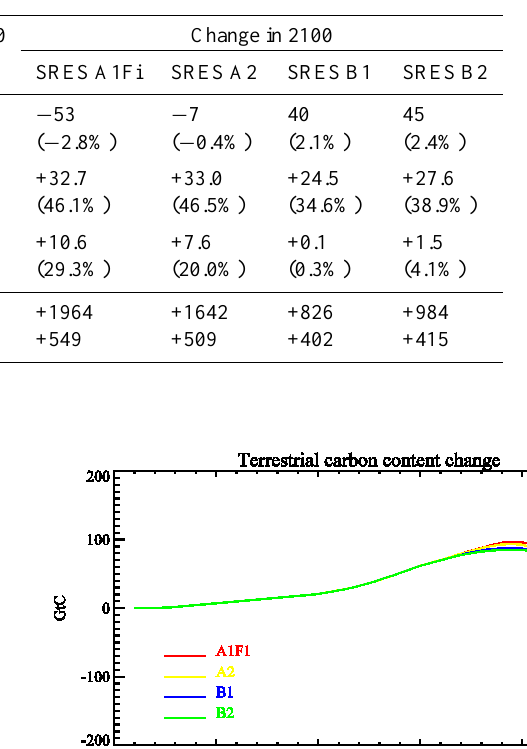
Table 1. Changes in total terrestrial carbon content, net primary productivity and runoff, relative to year 1860 and for four SRES scenarios, and all using EBM2. The year 1860 values are presented in the second column. Changes for period 1860 to 2100 are also expressed as percentages (in brackets). In addition, the change since year 1860 in atmospheric carbon and carbon sequestered by the ocean are also given (both in units of GtC, and positive numbers implying a gain).